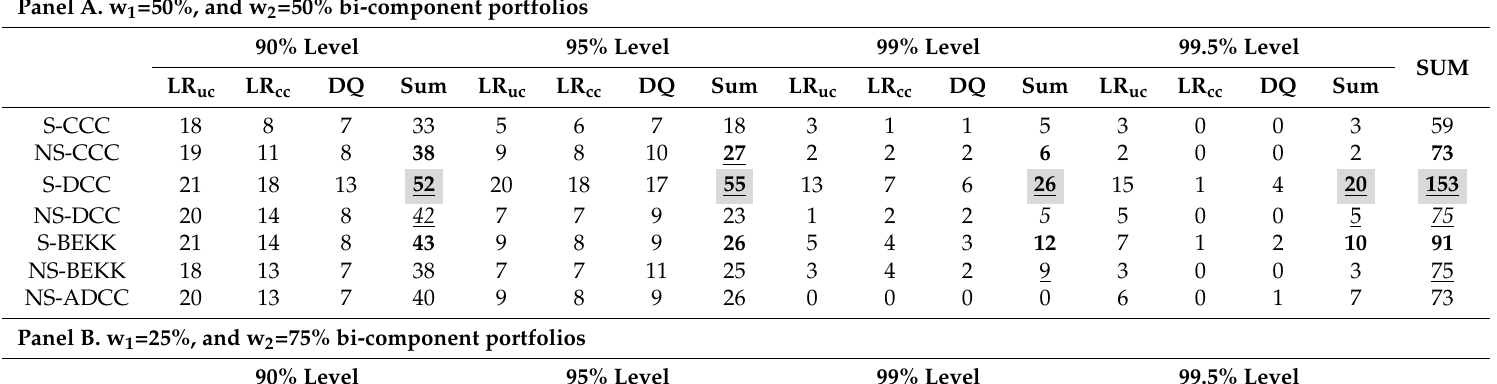
Table 8. All the summary results of the out-of-sample VaR forecast performances for the three weight combinations stock portfolios. Panel A. w 1 =50%, and w 2 =50% bi-component portfolios